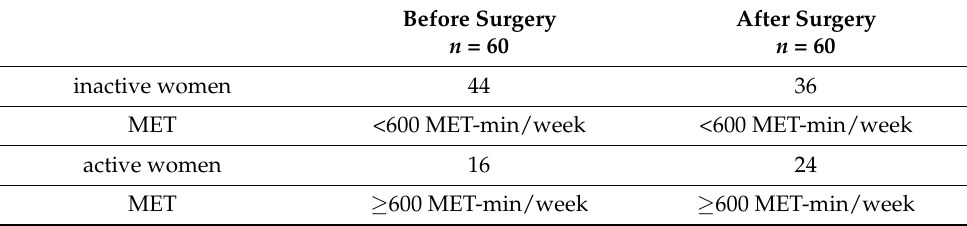
Table 2. Domain scores of the physically inactive and physically active women before and after surgery. Before Surgery After Surgery n = 60 n = 60 inactive women 44 36 MET <600 MET-min/week <600 MET-min/week active women 16 24 MET ≥ 600 MET-min/week ≥ 600 MET-min/week